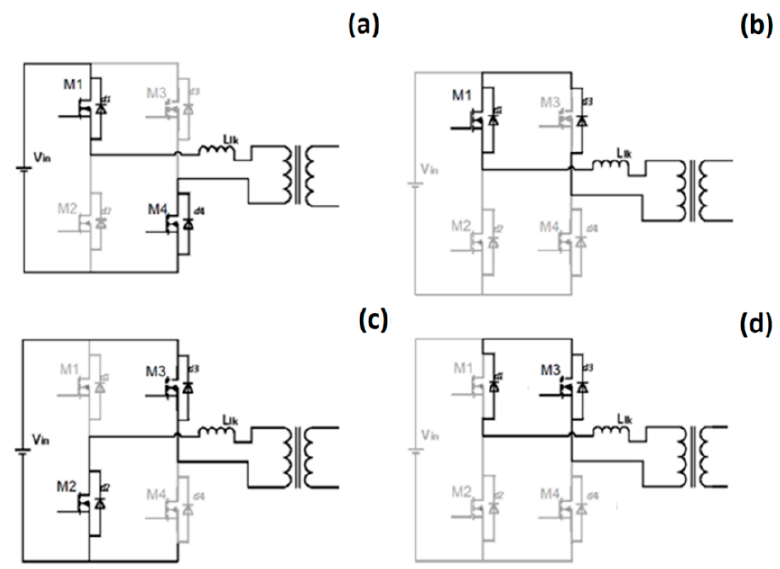
Figure 9. Equivalent circuits of full-bridge converter in four states of the developed control method. ( a , c )—supply state, ( b , d )—freewheeling state.